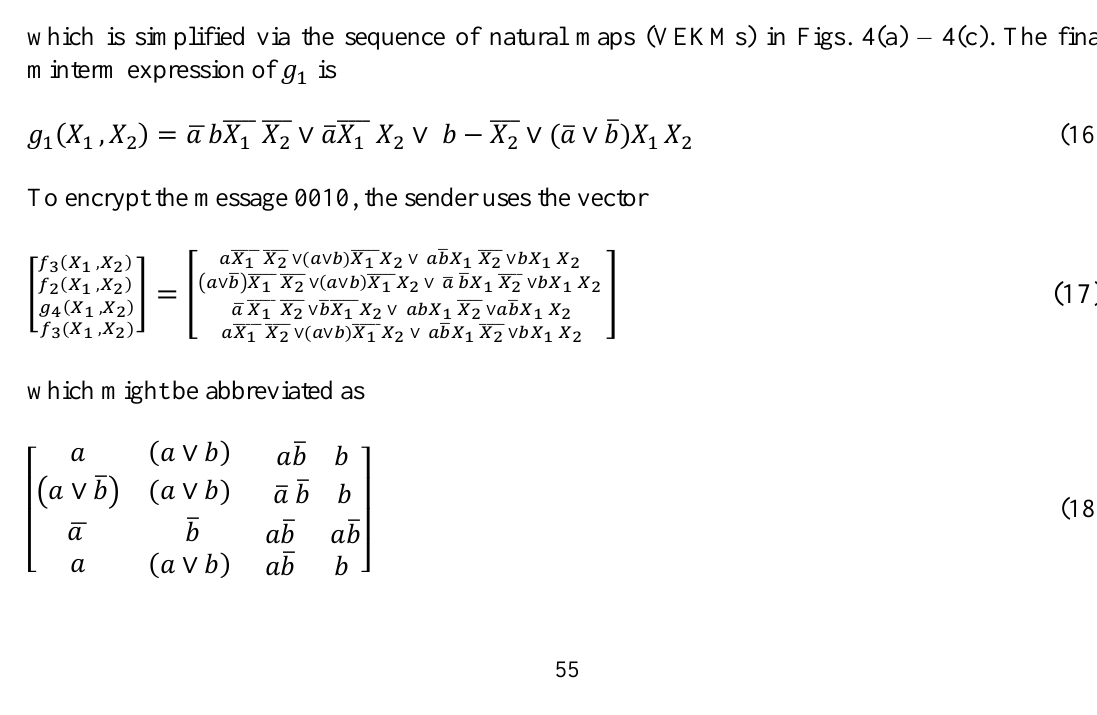
Fig. 4. Three consecutive instances of the natural maps (VEKMs) of 𝑔